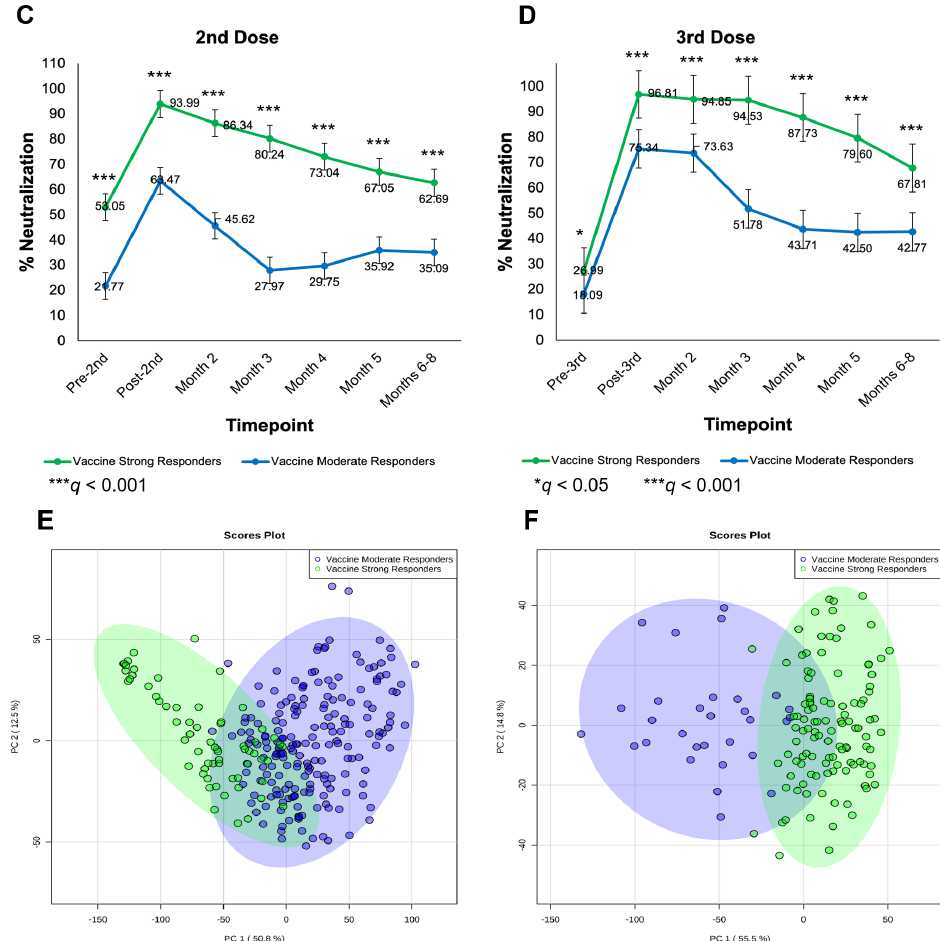
Figure 4. Second and third vaccine dose grouping analyses of unpaired longitudinal NAb data. ( A , B ) Unsupervised hierarchical clustering analysis performed using ( A ) 265 s dose subjects with percent neutralization data collected at pre-2nd dose, post-2nd dose, month 2, month 3, month 4, month 5, and months 6–8, and ( B ) 142 third-dose subjects with percent neutralization data collected at pre-3rd dose, post-3rd dose, month 2, month 3, month 4, month 5, and months 6–8. Dendrograms from both ( A ) and ( B ) show that the data are best classified as two groups such that within-group covariance is greater than between-group variance. In ( A ), 201 subjects were grouped as “vaccine moderate responders” while 64 subjects were classified as “vaccine strong responders” (VSR), while in ( B ), 30 subjects were classified as “vaccine moderate responders” (VMR) and 112 subjects were classified as “vaccine strong responders” (see ( C , D )). ( C , D ) Line graphs showing percent neutrali- zation by time following ( C ) 2nd dose and ( D ) 3rd dose between VSR and VMR. Data were grouped as indicated by unsupervised clustering ( A , B ). Error bars represent standard error. Significance de- termined by Mann–Whitney U test; FDR-controlled q values shown. * q < 0.05, *** q < 0.001. ( E , F ) PCA performed using percent neutralization values from ( E ) pre-2nd dose to months 6–8, and ( F ) pre-3rd dose to months 6–8. For both PCA score plots, subjects were classified as VSR or VMR via unsupervised clustering and significance analysis of measured differences in percent neutralization at each timepoint.